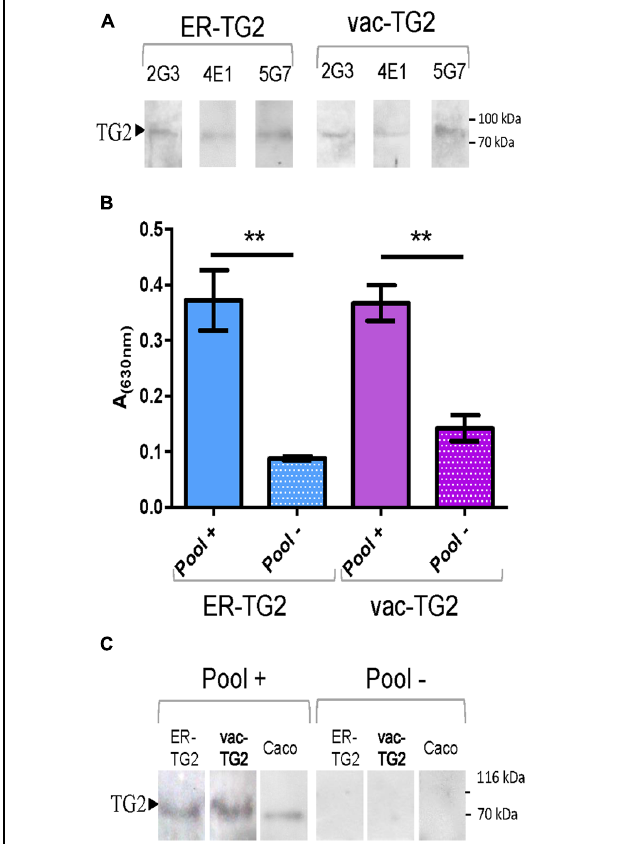
FIGURE 4 | Plant purified ER-TG2 and vac-TG2 as antigen for EC diagnosis. (A) Recognition of ER-TG2 and vac-TG2 by three different monoclonal antibodies (mAb). (B) ELISA with IgA sera of celiac patient and normal healthy donors. ∗∗ Denotes statistically significant difference by Student’s t -test ( P < 0.01). (C) Immunoblot with a pool of IgA sera of celiac patient (Pool + ) and normal healthy donors (Pool–). The protein loaded on the gel: ER-TG2, vac-TG2, caco extract is indicated at the top of the